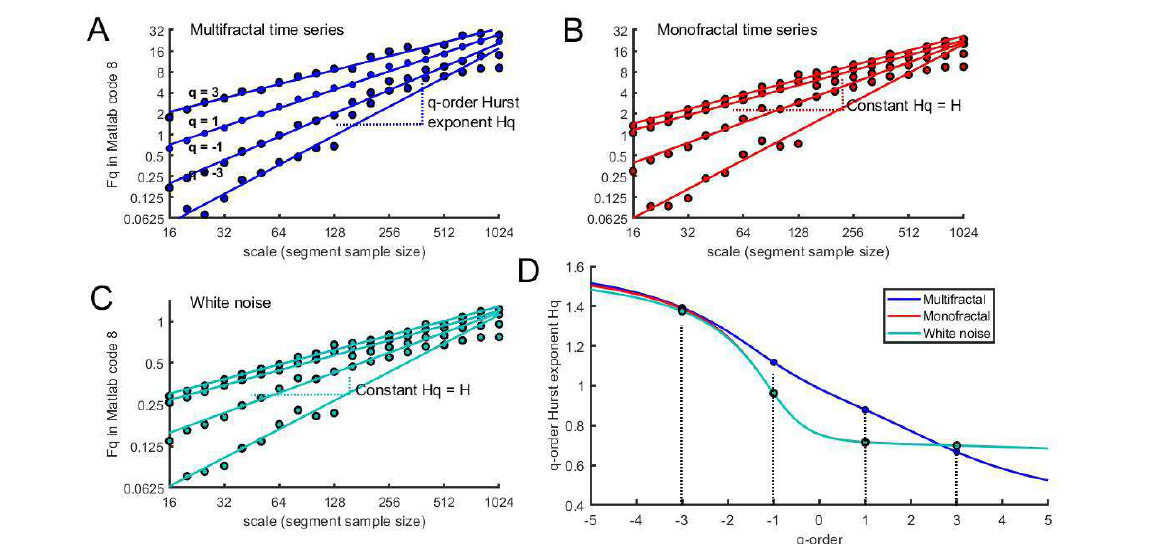
Figure 6. q th -order Hurst exponent for different time series